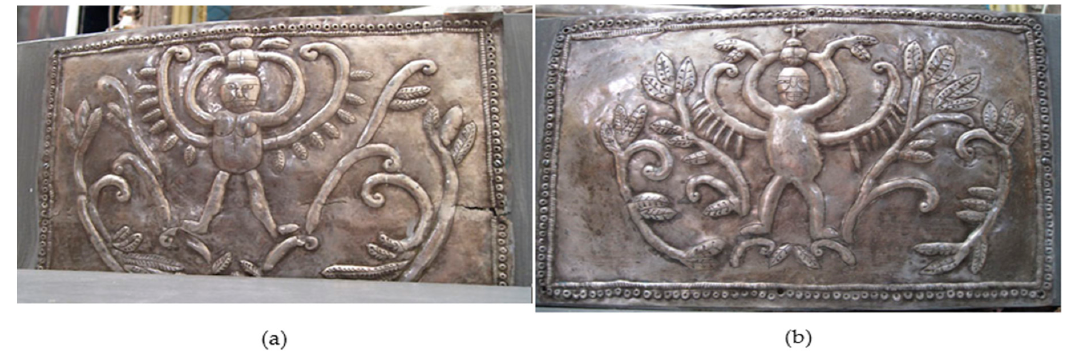
Figure 7. ( a ) Silver panel with female figure on the altar of the Virgin of Guadalupe, Sucre, Bolivia (photo: Andrea Nicklisch); ( b ) Silver panel with male figure on the altar of the Virgin of Guadalupe, Sucre, Bolivia (photo: Andrea Nicklisch).